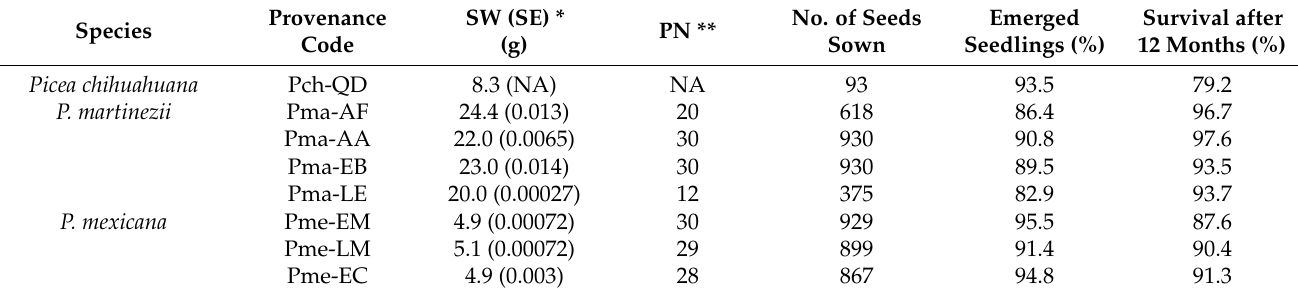
Table 4. Descriptive statistics for seed traits and survival rate of each provenance of the Mexican spruces studied (* SW = weight of 1000 seeds, SE = standard error, NA = not available; ** PN = number of progenies